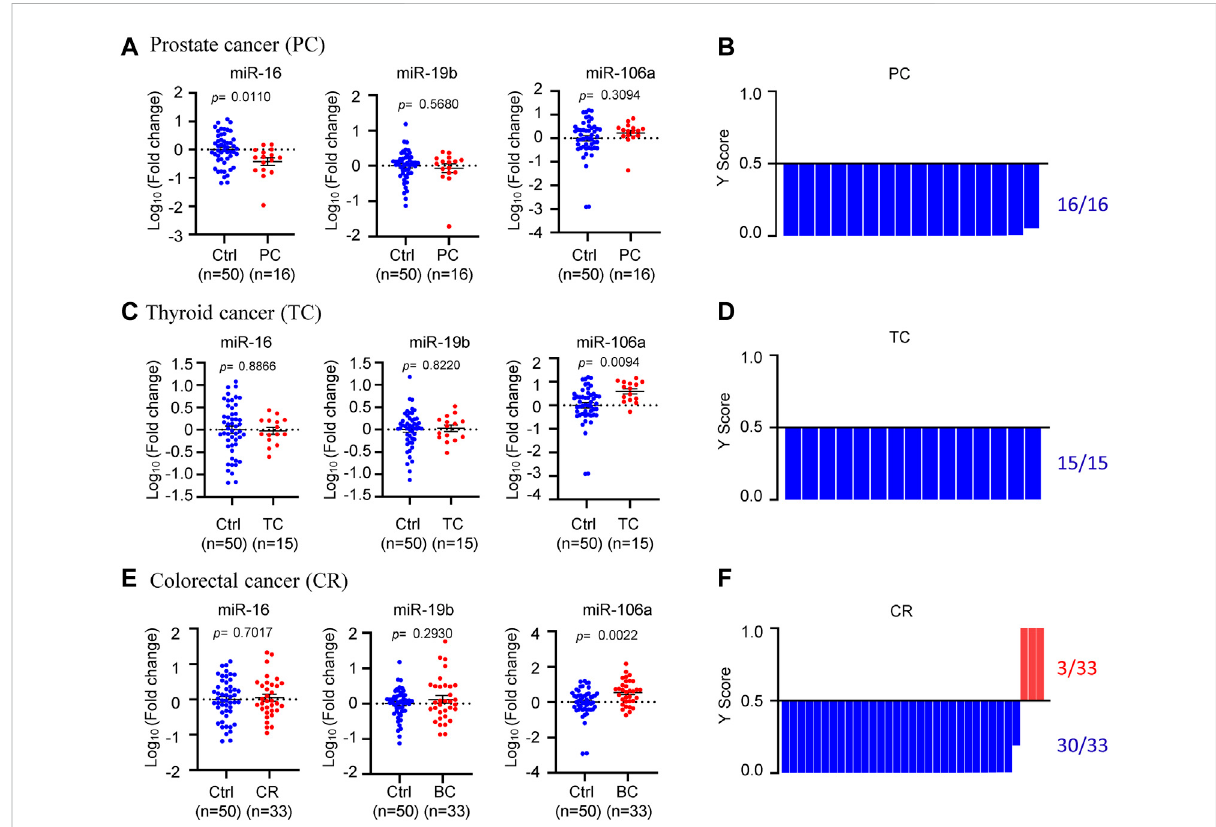
FIGURE 6 Speci fi city validation of the model. (A) , (C) , (E) . The expression levels of circulating miR-16, miR-19b, and miR-106a in 16 prostate cancer patients (A) ,15thyroidcancerpatients (C) and33colorectalcancerpatients (E) ,comparedto50normalcontrols. (B) , (D) , (F) .Yscoredistributionplot ofthemiR-19b-based3-miRNAmodel (model3)inthethree othertumortypes,showing100% negativeofBCinthe16 prostate cancerpatients (B) , 100% negative of BC in the 15 thyroid cancer patients (D) and 91% negative of BC in the 33 colorectal cancer patients (F) . Y score > 0.5 was diagnosed as